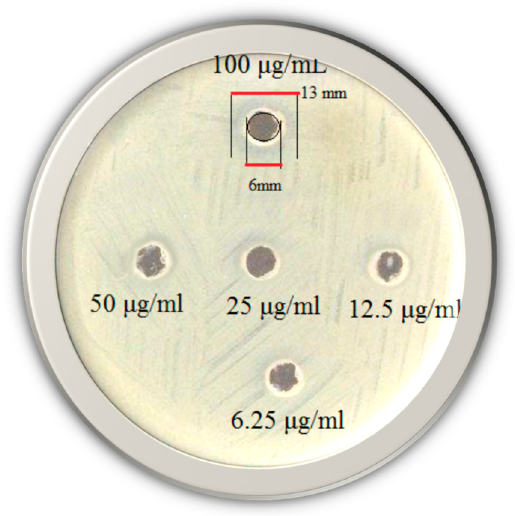
Figure 7. Photographic images of HapyTSCmB’s ability to inhibit the bacterial growth at concentrations of 6.25–100 μ g/mL against Staphylococcus aureus .